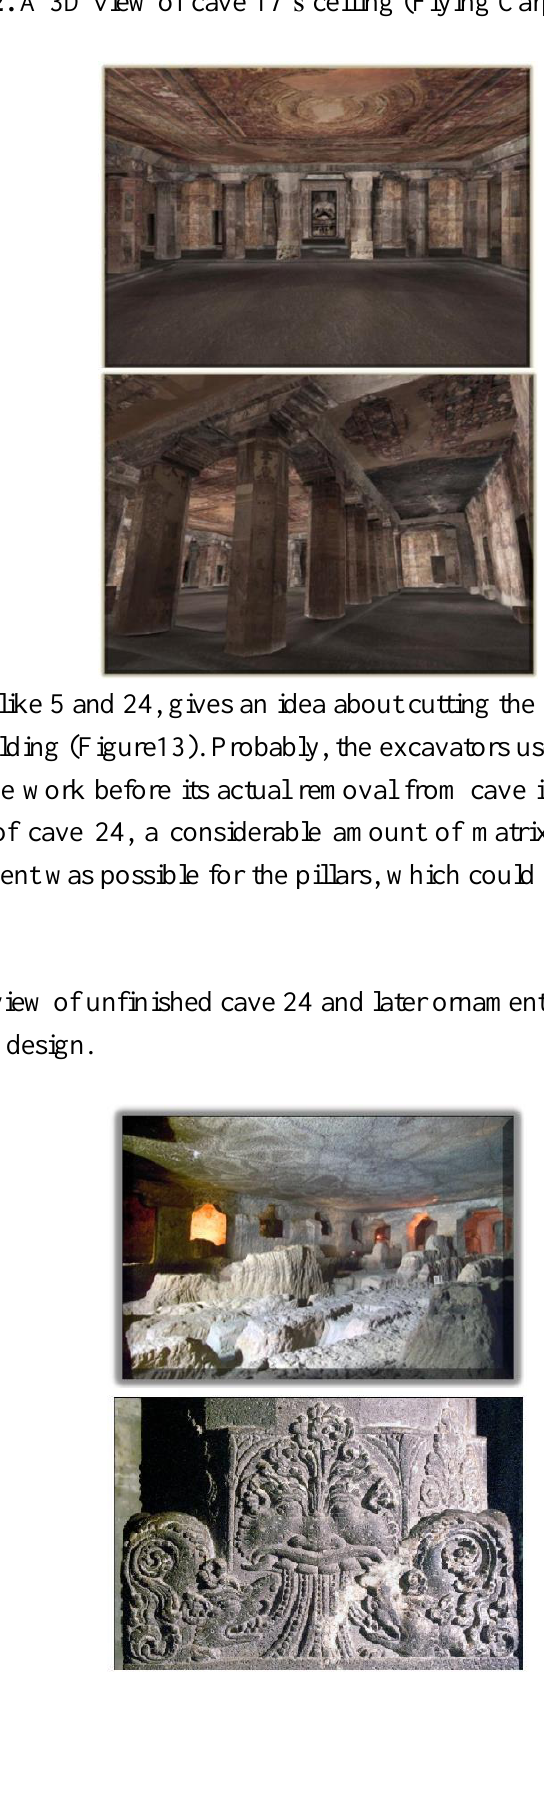
Figure 12. A 3D view of cave 17’s ceiling (Flying Carpet) and aisle.